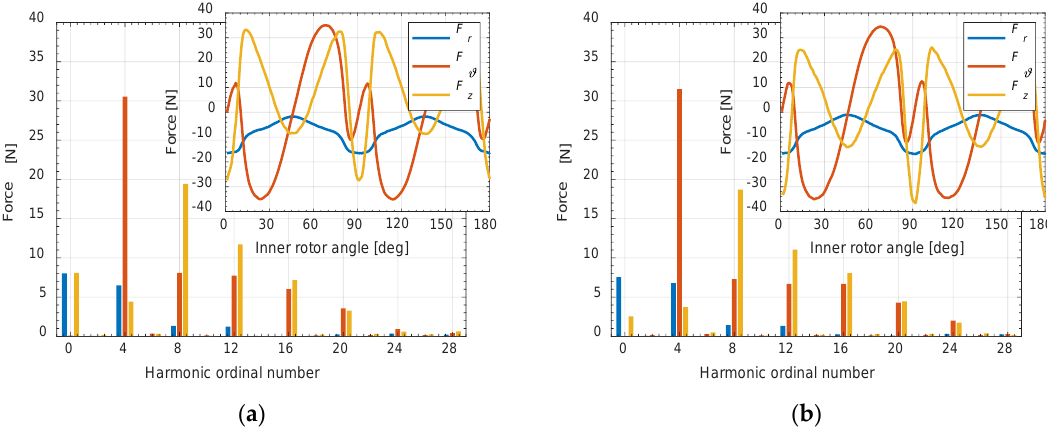
Figure 7. Force components acting on a selected SMC modulator core and their FFT spectra at no load for two gear variants: ( a ) MG 1 ( b ) MG 2.